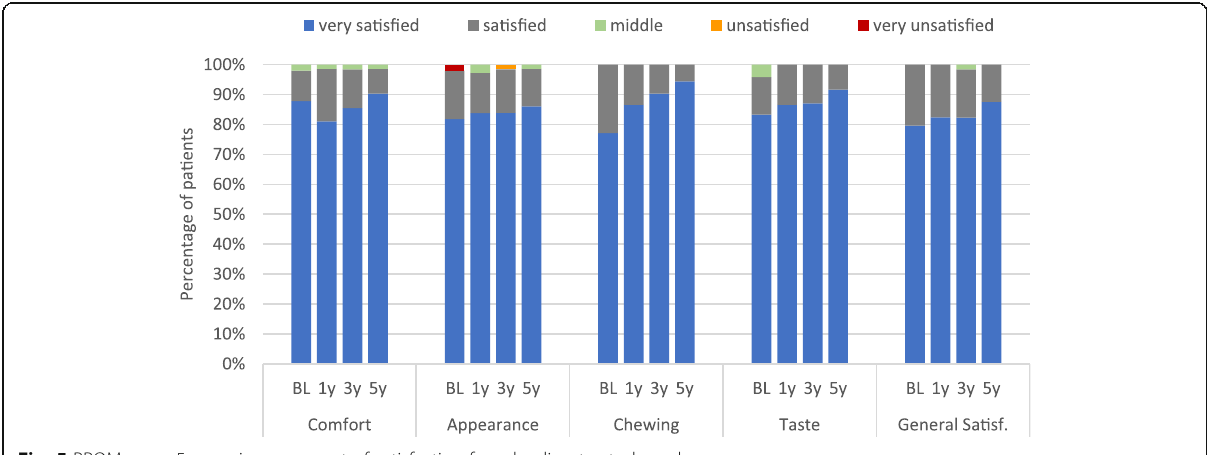
Fig. 5 PROMs over 5 years: improvement of satisfaction from loading to study